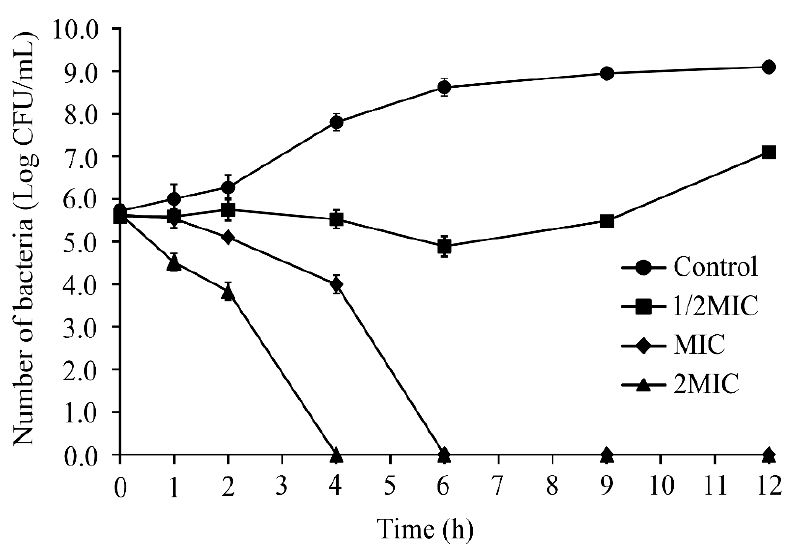
Figure 2. Inactivation of S. Typhimurium by CoQ 0 in LB. ( ∎ ) Control, ( ● ) 1/2MIC, ( ▲ ) MIC, ( ♦ ) 2MIC. Control represents no CoQ 0 added.